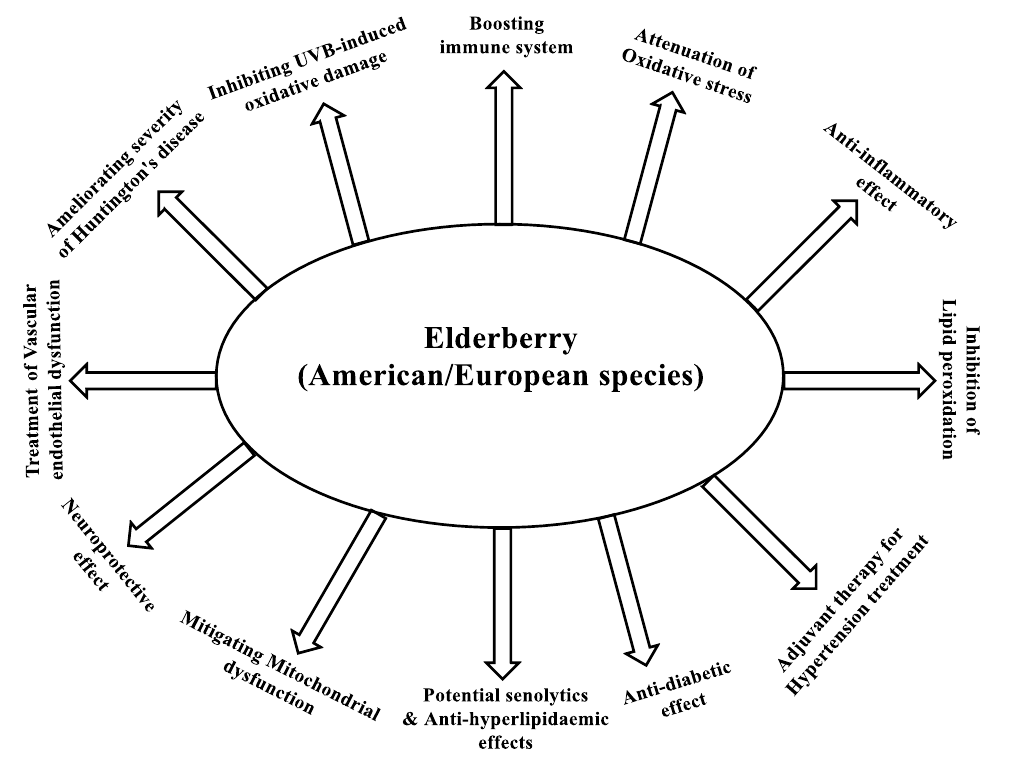
Figure 2. Pharmacological effects and health benefits of elderberry.